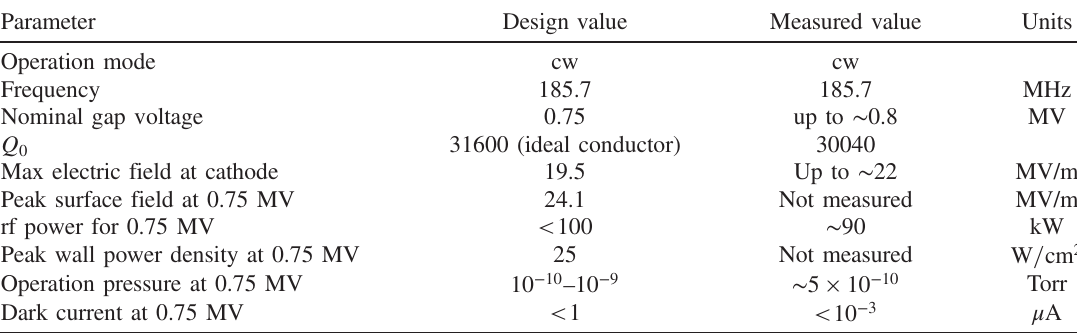
TABLE I. Existing APEX VHF-gun parameters: Design and demonstrated values. Parameter Design